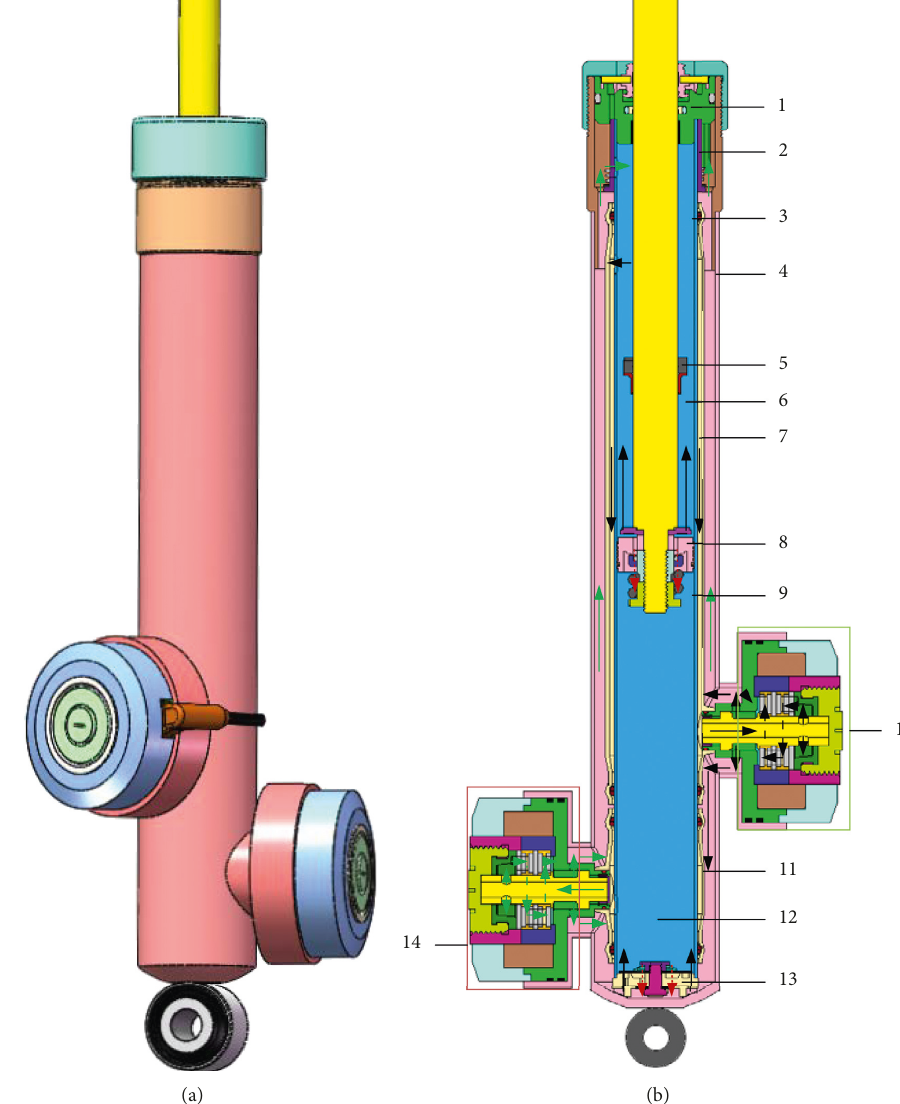
Figure 44: Schematic diagram and cross-sectional view of MR damper with controlling damping force independently for compression and rebound: 1, guiding assembly; 2, check valve assembly; 3, piston rod; 4, outer cylinder; 5, buffer; 6, rebound chamber; 7, upper intermediate cylinder; 8, piston assembly; 9, inner cylinder; 10, first valve for rebound; 11, lower intermediate cylinder; 12, compression chamber; 13, foot valve; 14, second valve for compression